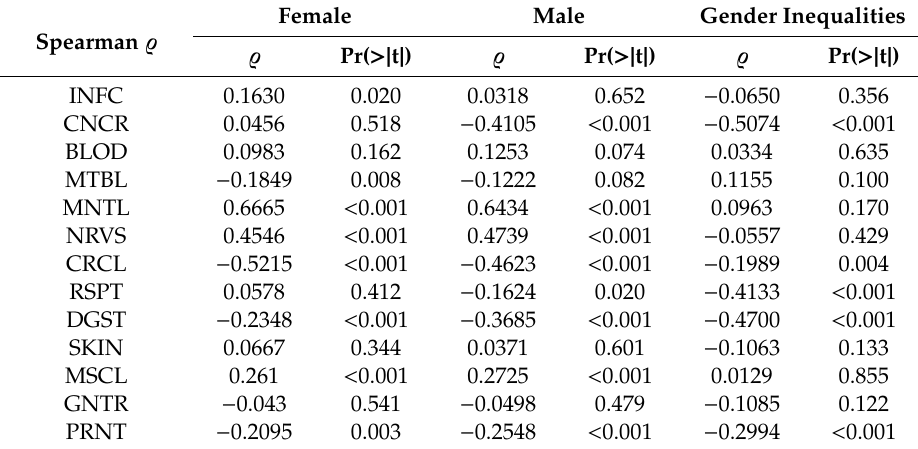
Table 3. Analysis of